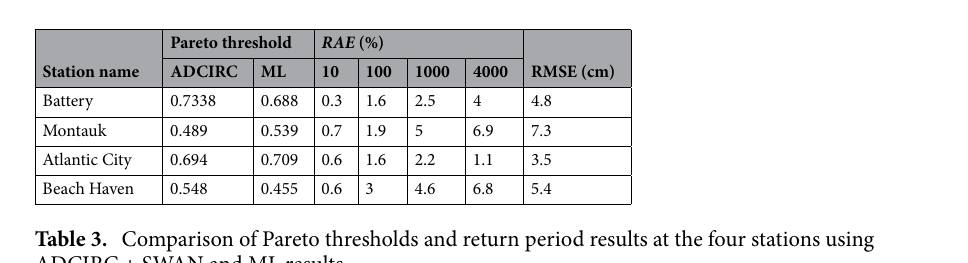
Figure 7. Comparison of return period curves with confidence intervals at the four study sites using peak storm surge generated by ADCIRC + SWAN and ML models.